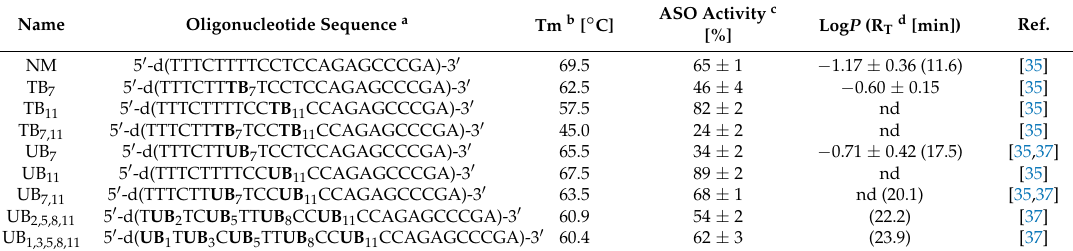
Scheme 8. Antisense UB-type DNA oligonucleotide targeted EGFR obtained via Cu(I)-assisted “click” conjugation, bearing five Fe (III)-metallacarborane units. Hydrogen atoms of C–H groups and B–H groups of the boron clusters, symbolized by the polygen vertex, were omitted for clarity. Table 1. Binding affinity of the anti-epidermal growth factor receptor (EGFR) metallacarborane antisense oligonucleotides to the complementary RNA strand assessed by thermal dissociation assay (Tm), lipophilicity (Log P ), RP-HPLC mobility (retention time R T ), and antisense activity (antisense oligodeoxyribonucleotide (ASO) activity) assessed by a dual fluorescence assay (DFA) against EGFR